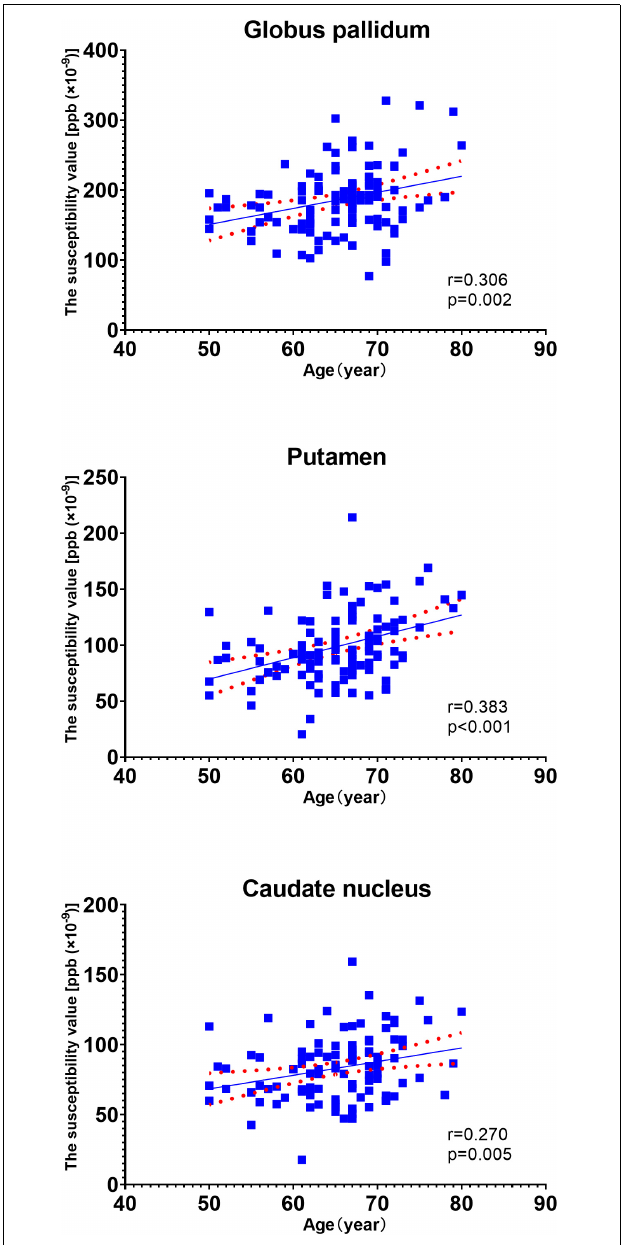
FIGURE 3 | Scatter plots illustrating a linear age dependency of iron concentration as measured by mean quantitative susceptibility mapping (QSM) susceptibility values. The putamen exhibited the highest rate of increase in susceptibility values with